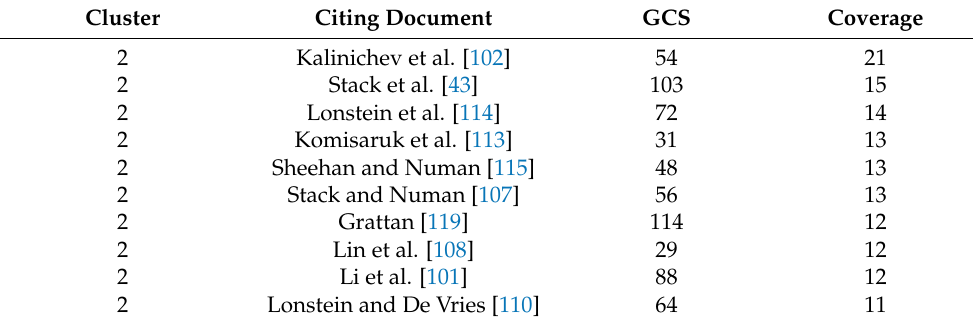
Table 5. Major 10 citing documents in cluster #2 identified using the